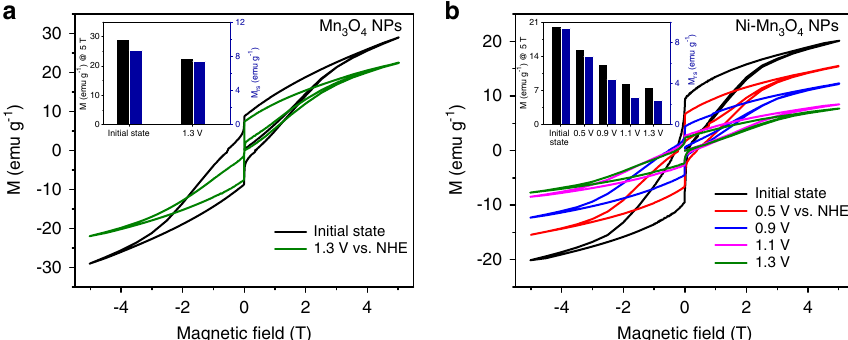
Fig. 4 Potential-dependent magnetization measurements using a SQUID. a , b Potential-dependent magnetic hysteresis curves for Mn 3 O 4 NPs a , and Ni – Mn 3 O 4 NPs/NiO b , measured at 5 K. Compared to Mn 3 O 4 NPs, Ni – Mn 3 O 4 NPs/NiO shows signi fi cantly diminished magnetization under the applied anodic potential. The black and blue histograms in inset fi gures show the magnetization values at 5 T and 0 T ( M rs ),